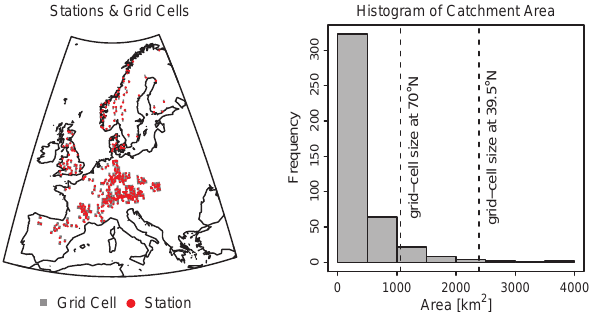
Figure 1. Runoff observations. Left: locations of the gauging sta- tions of the considered catchments, as well as the grid cells with ob- servations. Right: histogram of catchment areas. The vertical lines indicate the grid-cell size of the southern and northernmost grid cells. Figure 2. Median grid-cell slope.